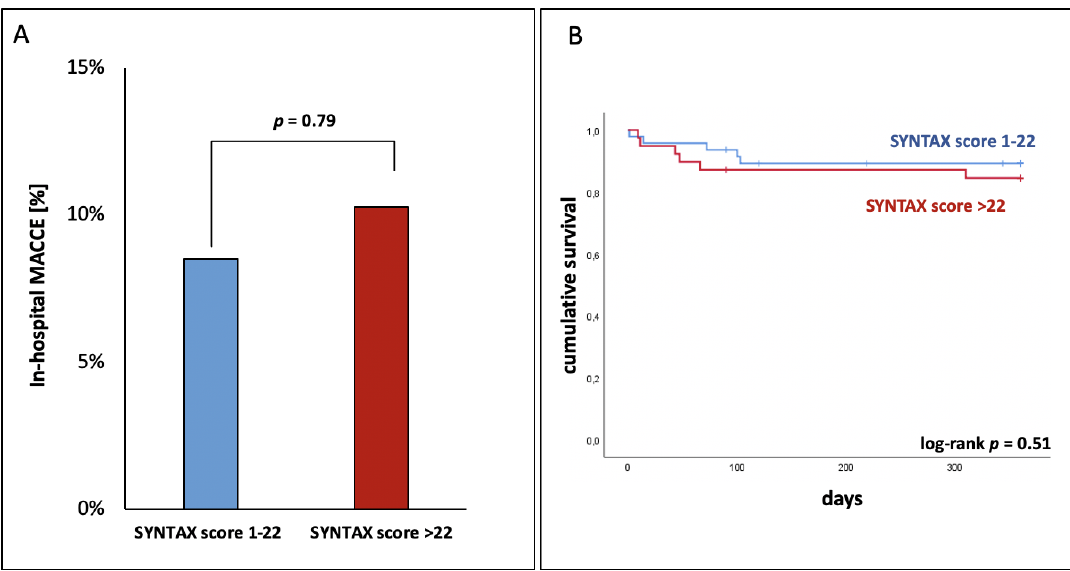
Figure 2. Association of coronary anatomical complexity with clinical outcomes in diabetic patients. ( A ) In-hospital MACCEs and ( B ) Kaplan–Meier estimates of one-year survival according to baseline SYNTAX I score; DM: diabetes mellitus; MACCE: major adverse cardiac and cerebrovascular events.